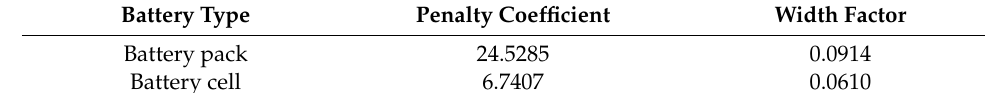
Table 1. The optimized penalty coefficient and width factor of SVM in the proposed method.